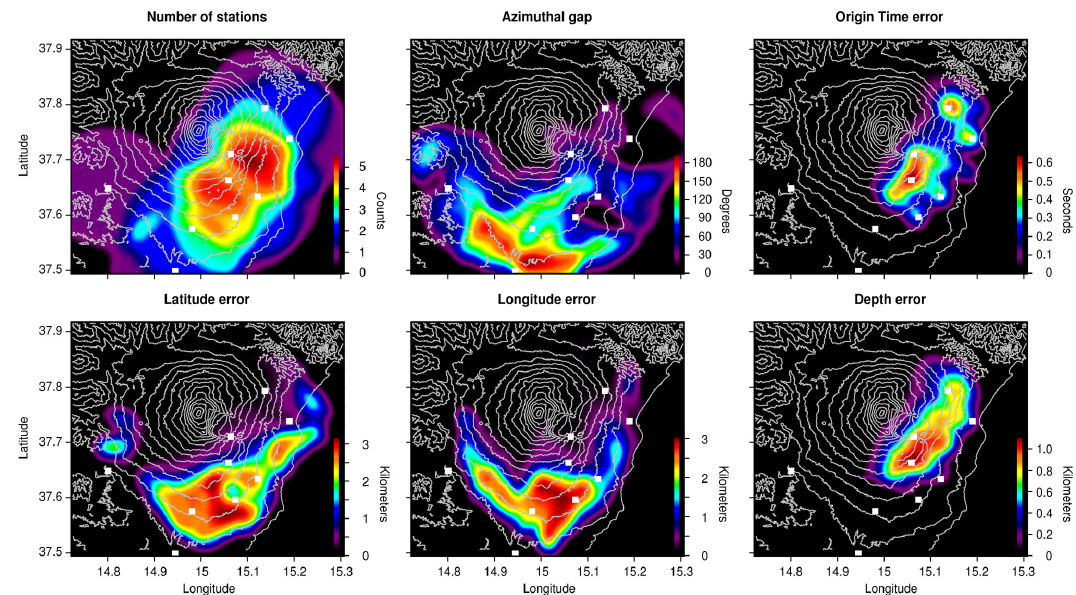
Fig. 7. SNES maps for (ESN + CS) − ESN at M L 1.5, hypocentral depth of 5km and confidence level of 95%.